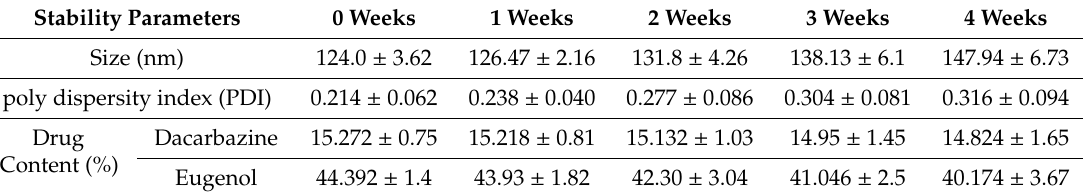
Table 7. Storage